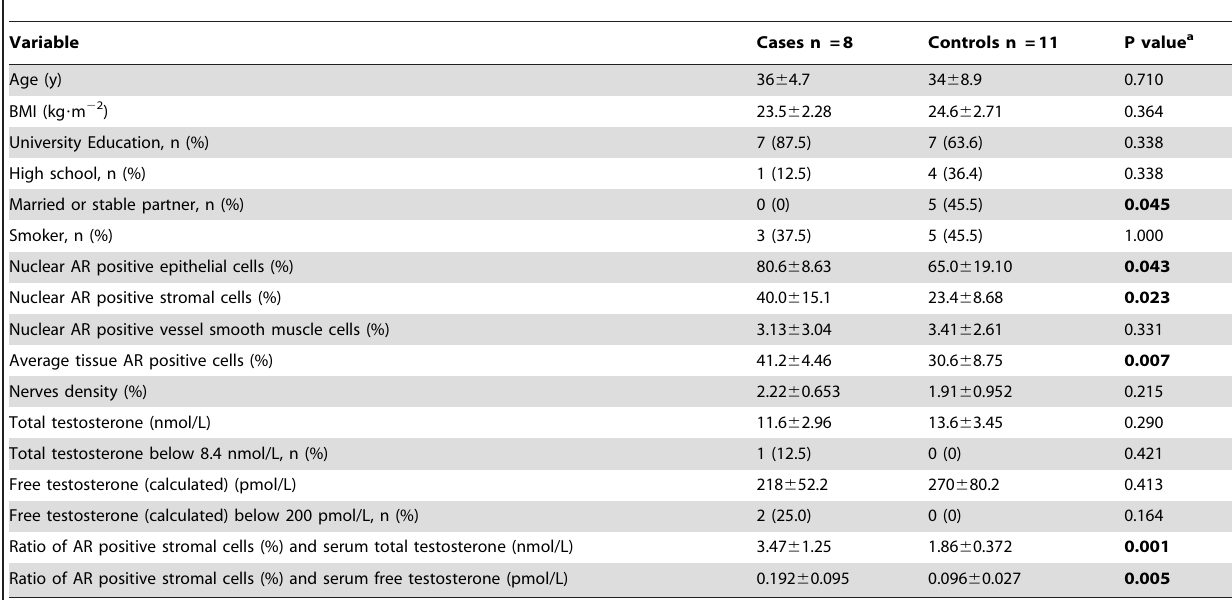
Table 2. Comparison of demographics features, immunohistochemical findings and serum hormonal levels between 8 cases and 11 controls.